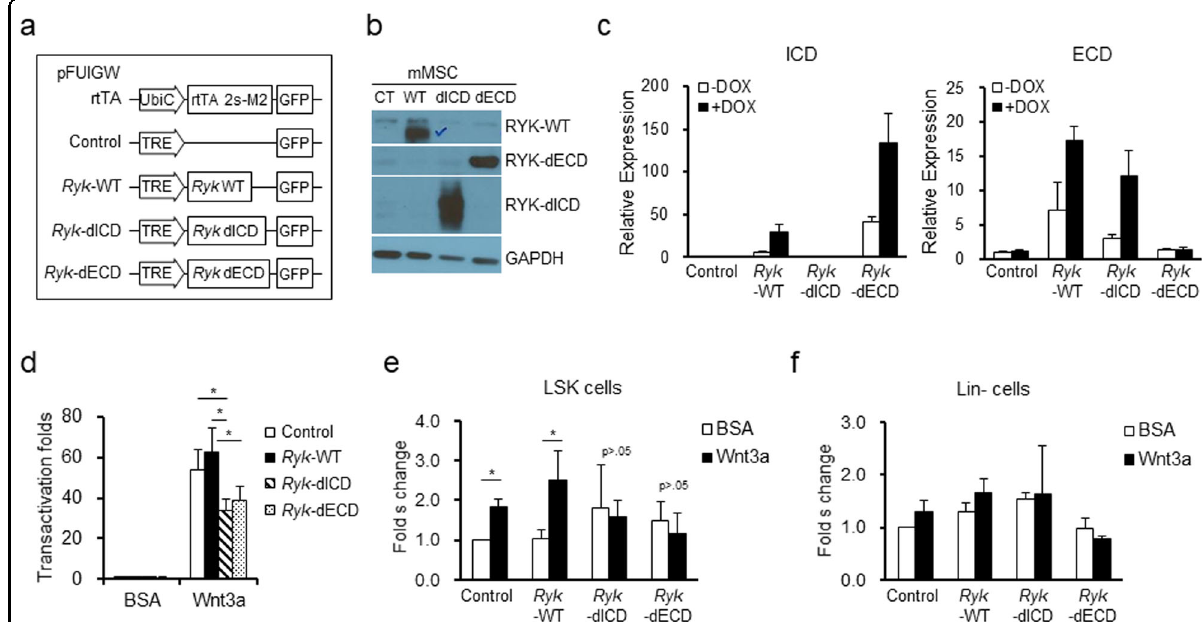
Fig. 5 The niche-modulating effect is dependent on the intracellular domain of Ryk. a Schematic structures of vectors for doxycycline-inducible expression of WT and the mutants with a deletion of the intracellular domain (dICD) or extracellular domain (dECD) of Ryk. b Validation of transgenic expression of Ryk and its mutants in MSCs. MSCs transfected with each construct were doxycycline induced and sort-puri fi ed by GFP and examined for protein products of the construct. The Western blot analysis for WT and mutants ( Ryk -dICD, Ryk -dECD) detected by an antibody against RYK is shown. c Validation of expression by qRT-PCR. The fold expression of each construct in the presence or absence of doxycycline (1 µg/ml) detected by PCR primers speci fi c to the intracellular domain (ICD) (left) or extracellular domain (ECD) (right) of Ryk is shown. d Effect on transactivation of Wnt target genes. The transactivation folds of each indicated construct in MSCs normalized to the BSA-treated control group (mean ± SEM, * p < 0.05, n = 3) are shown. e , f Effects on HPC supporting activity. Each group of MSCs was cocultured with HPCs for 5 days to compare their niche activity supporting the self-renewing expansion of HPCs in the presence or absence of Wnt3a. The fold changes in the numbers of primitive HPC subsets (LSK) and lineage negative (Lin − ) populations are shown (mean± SEM, * p < 0.05, n =